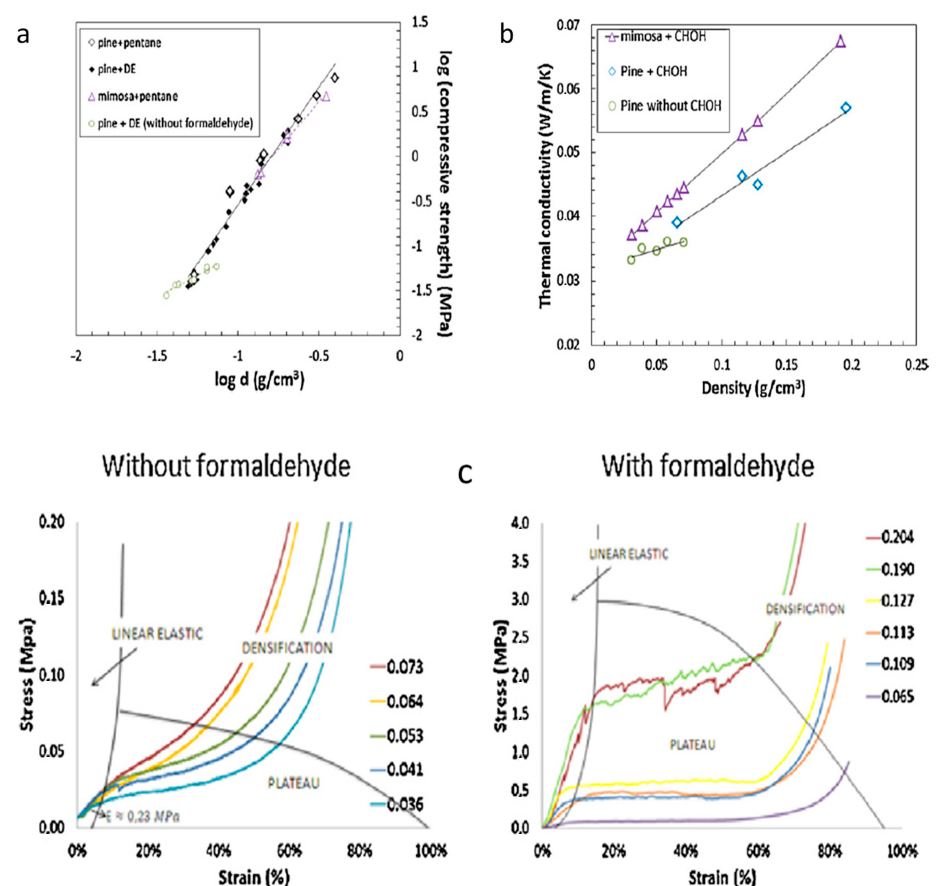
Figure 14. ( a ): Thermal conductivity, ( b ) compressive modulus, and ( c ) stress–strain curves Figure 14. a : Thermal conductivity, b compressive modulus, and c stress – strain curves [80]. Pure green tea extract (GTE) from Camellia sinensis and catechin hydrates (GTE’s main